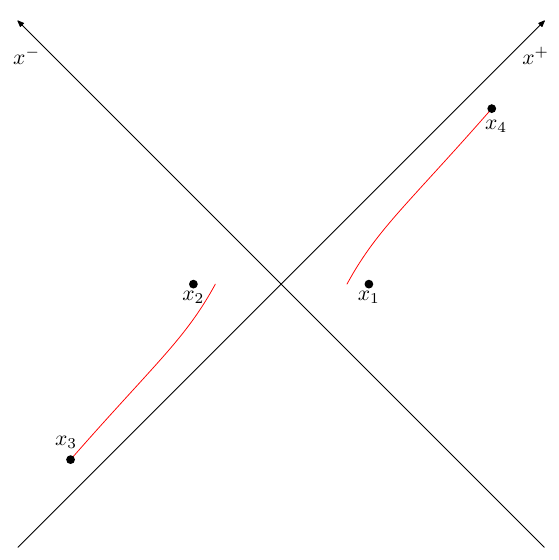
Figure 1 . The Regge limit corresponds to taking t → ∞ in